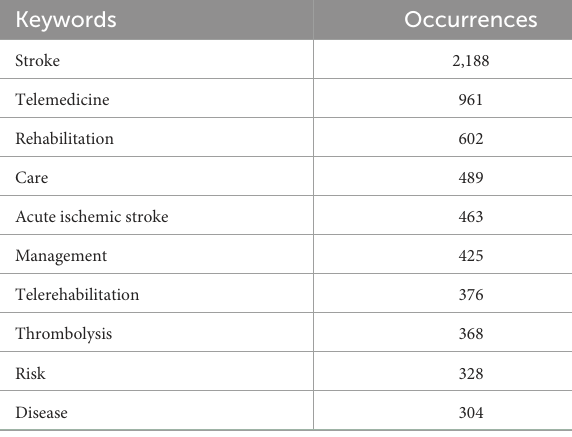
TABLE 2 The top 10 keywords in the published literature of this specialized field. Keywords